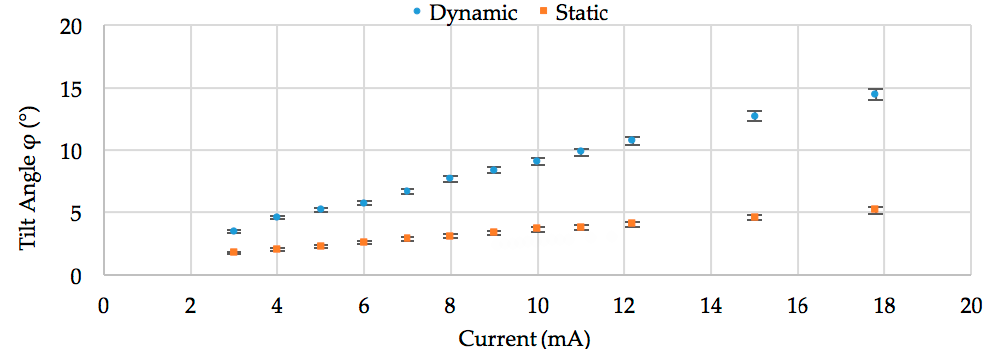
Figure 4. Angle of φ tilt mode vs. current. Red squares show the tilt angle with dc current, and the blue circles show the tilt angle with ac current of 238 Hz, using configuration of Figure